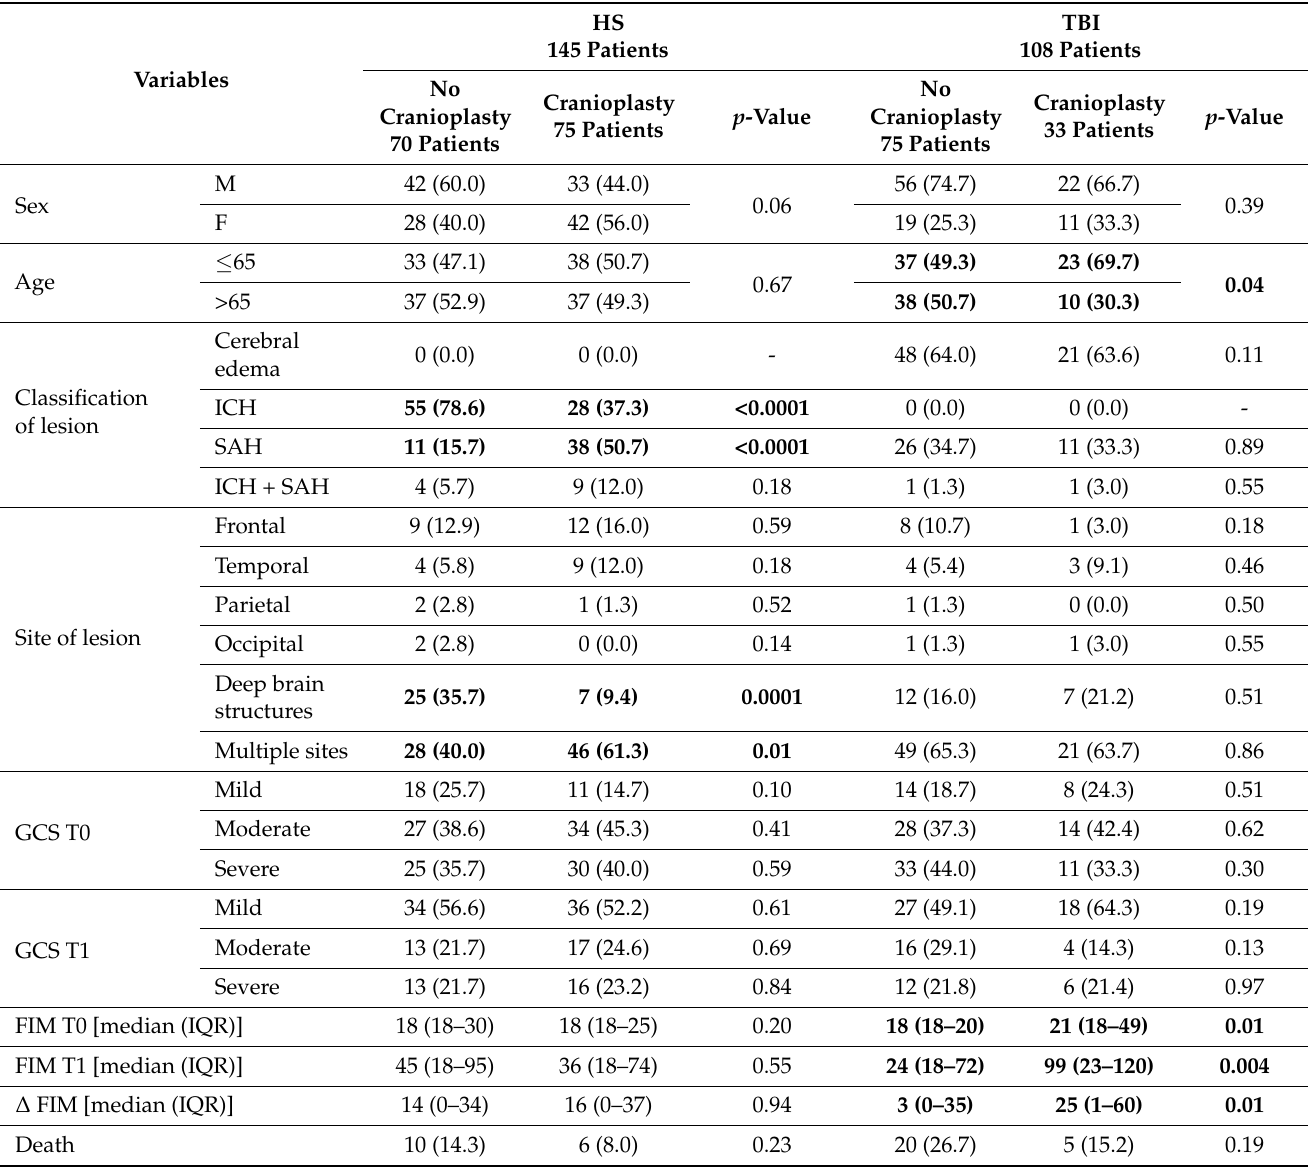
Table 2. Clinical and rehabilitation characteristics of the population sub-grouped according to the type of brain